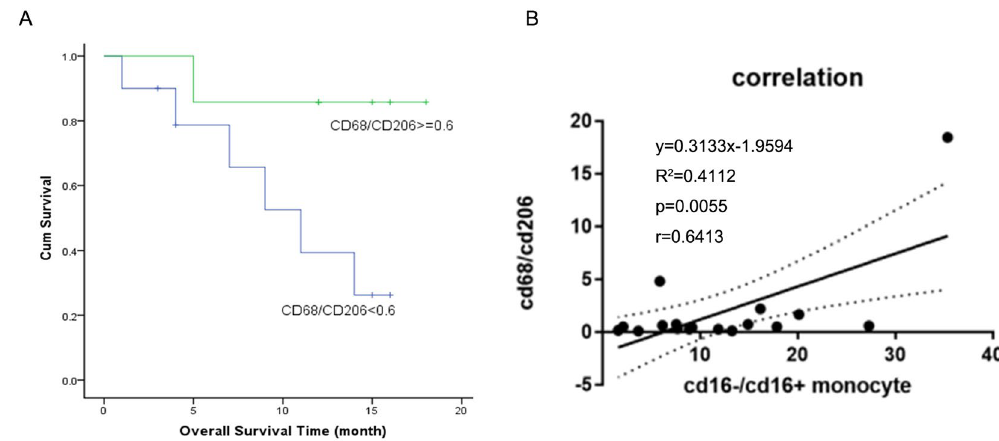
Figure 3. Role of CD68/CD206 macrophages in predicting T-NHL overall survival and its relationship with CD16 − /CD16 + monocytes. ( A ) Kaplan–Meier analysis of overall survival indicated that the 1-year overall survival rate was 0.857 ± 0.132 for patients with tissue CD68/CD206 macrophages ratio ≥ 0.6, which was significantly better than those with low CD68/CD206 macrophages ratio (0.263 ± 0.158). ( B ) Pearson analysis indicated a correlation between tissue CD68/CD206 macrophages and peripheral CD16 − /CD16 + monocytes (p = 0.006, r =